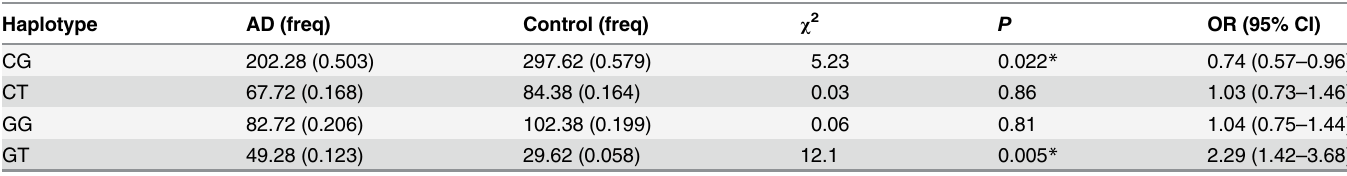
Table 8. Correlation analysis between ANP gene haplotypes and AD.